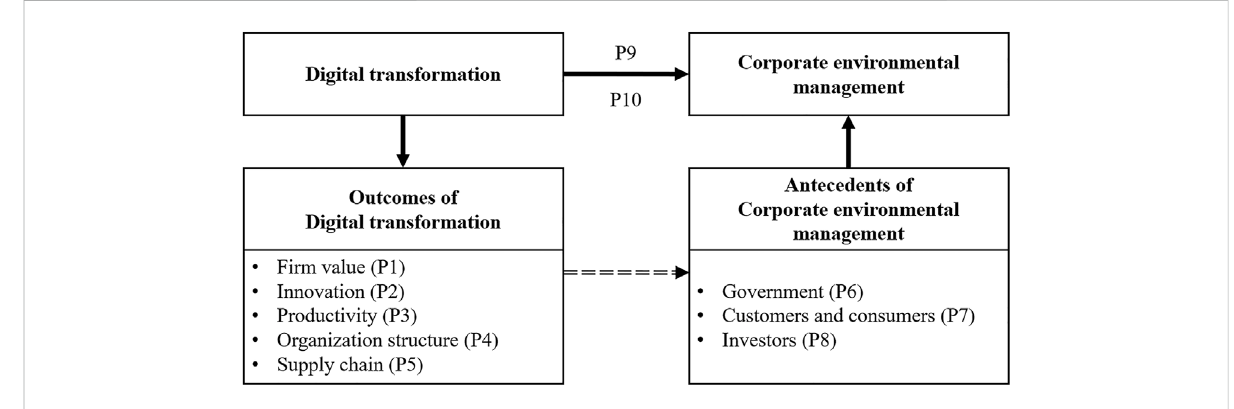
FIGURE 4 Mechanisms of digital transformation for corporate environmental